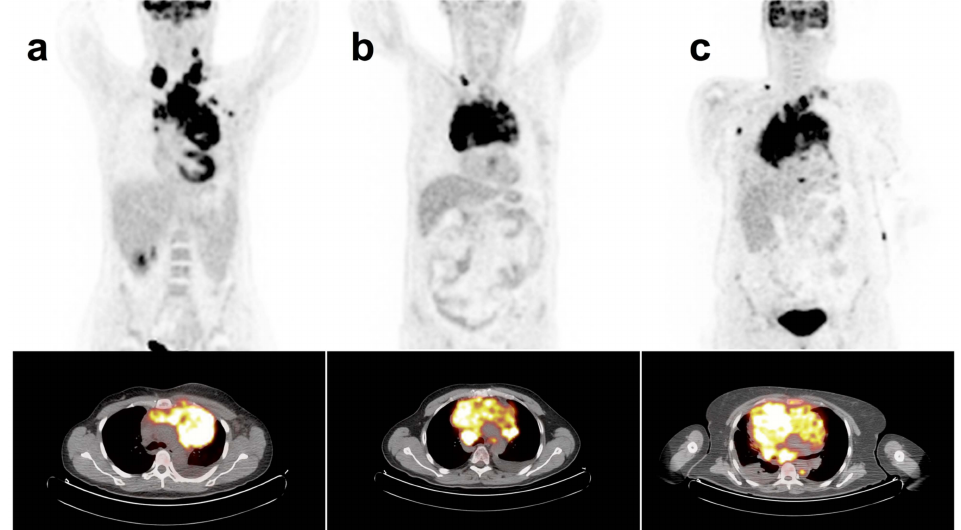
Figure 1. 18 F-FDG-PET/CT maximum intensity projection (MIP) and mediastinal transaxial images show the mediastinal bulky mass in patient with ( a ) cHL, ( b ) GZL and ( c )